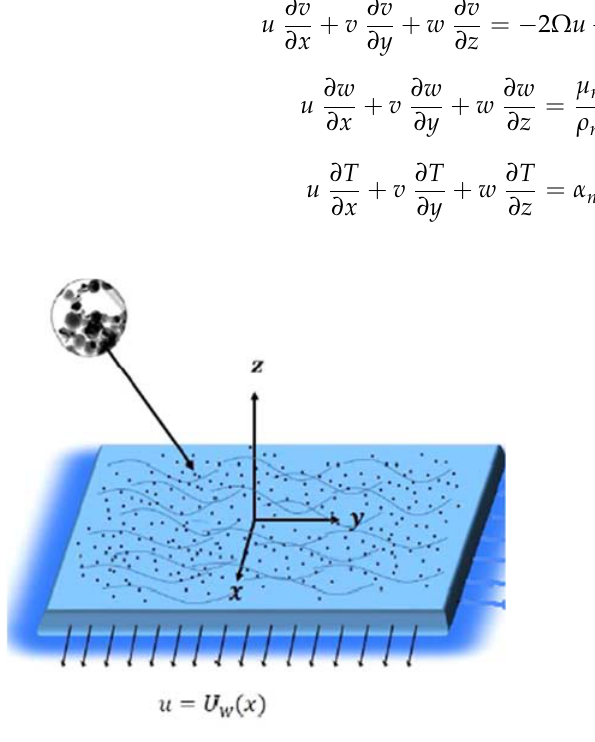
Figure 1. Geometry of the problem.